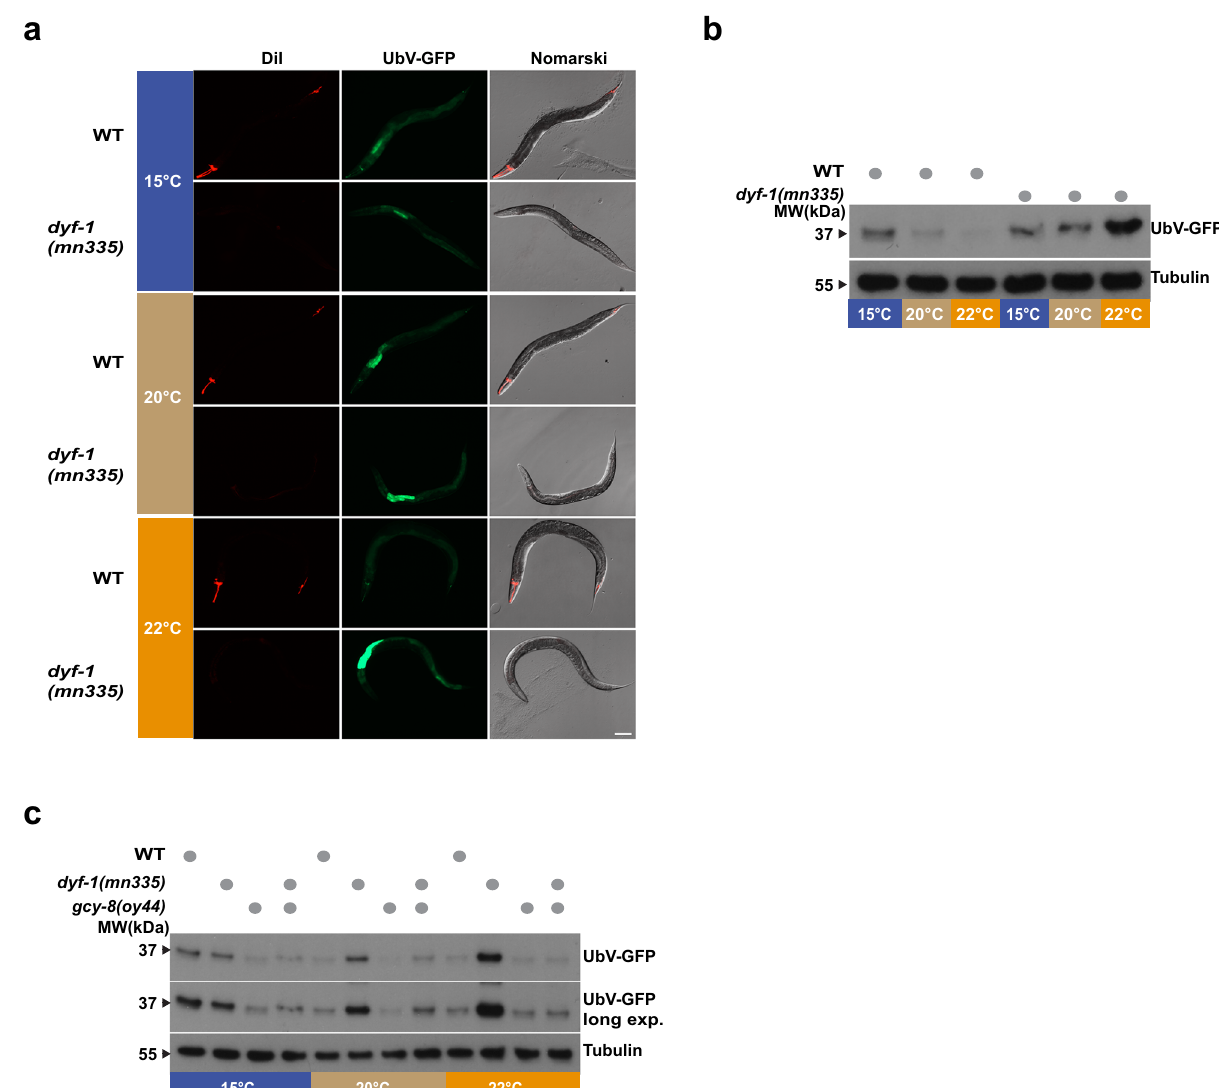
Fig. 7 | Sensory temperature perception adjusts protein turnover. a FluorescenceandNomarskiimagesofwormsexpressingtheUFDsubstrate(UbV- GFP) in WT or dyf-1(mn335) mutant worms grown at different temperatures as indicated. DiI denotes ciliated amphid and phasmid neurons. n =3 biologically independent experiments. Scale bar 100 μ m. b Protein lysates of worms displayed in ( a ) were analysed by SDS-PAGE and immunoblotting against GFP and tubulin as